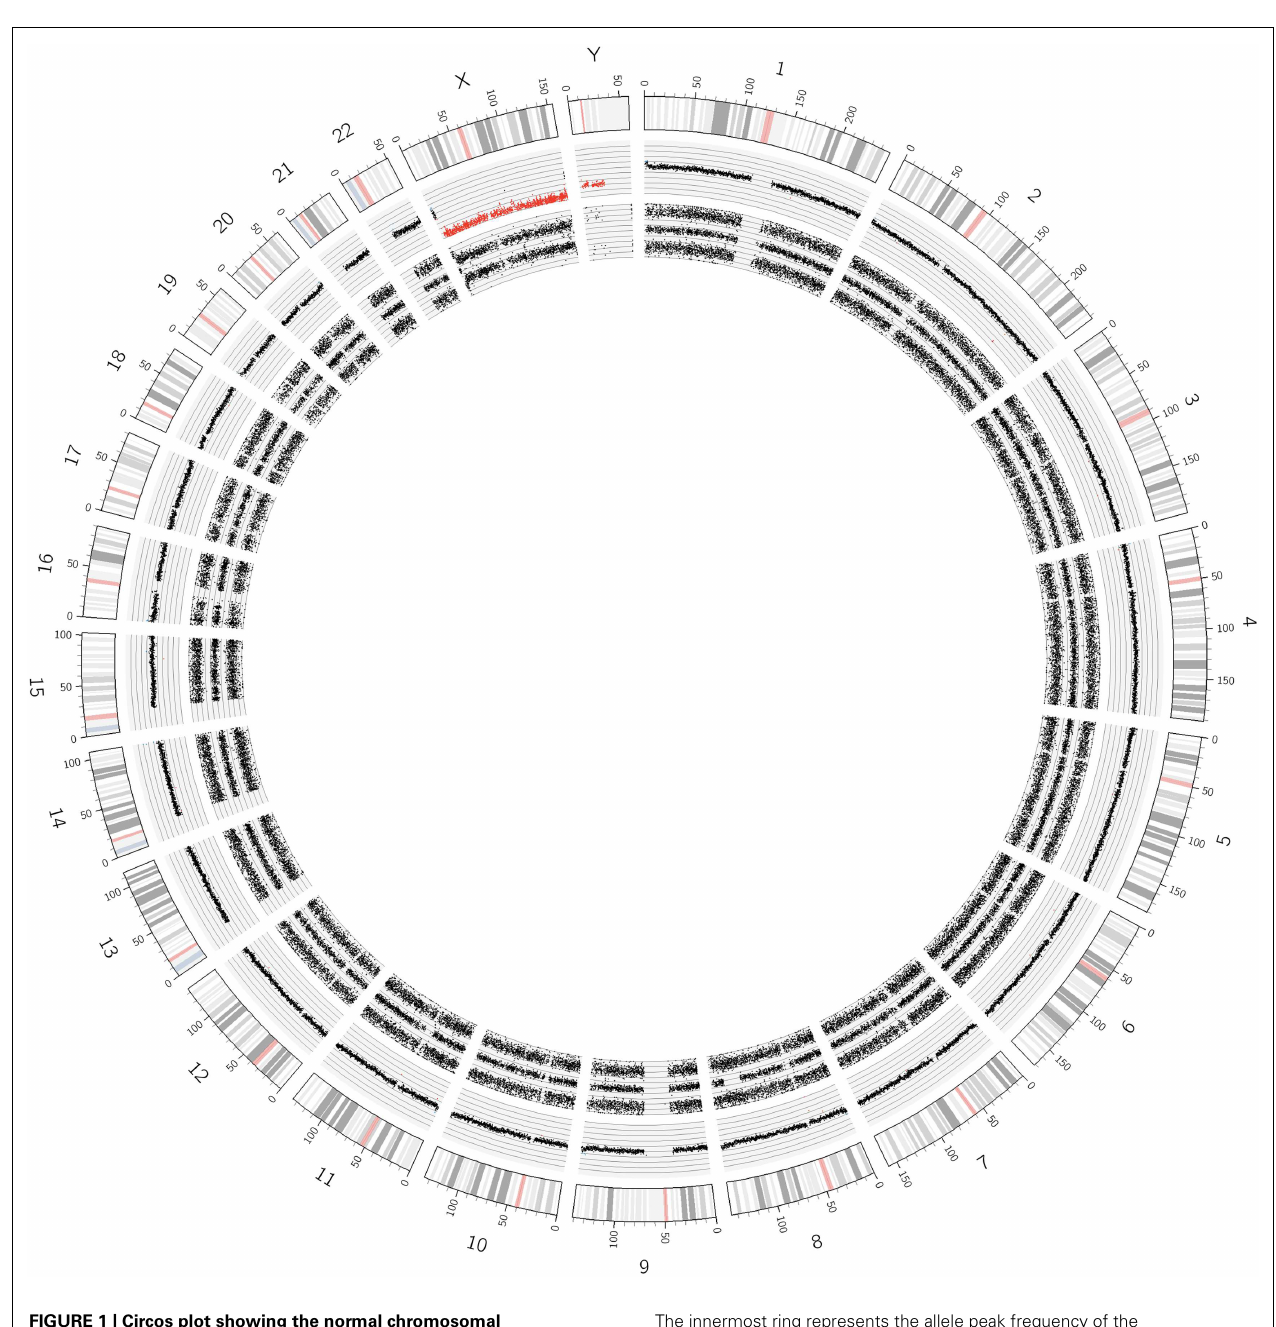
FIGURE 1 | Circos plot showing the normal chromosomal complement from a Schwann cell dominant tumor .The outer ring indicates the chromosome ideograms and distances in Mb.The next ring indicates the copy number information. All autosomes are disomic (black dots), the X andY chromosomes are present in one copy each (red dots).